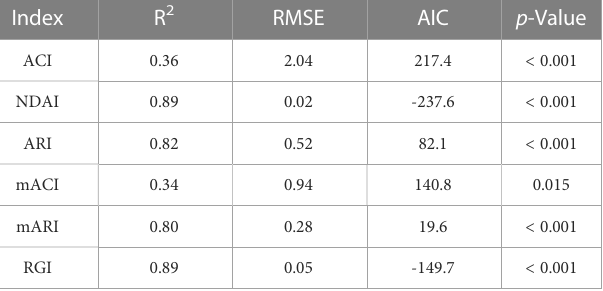
TABLE 1 Statistical summaries of various indices for anthocyanin content (n = 50).